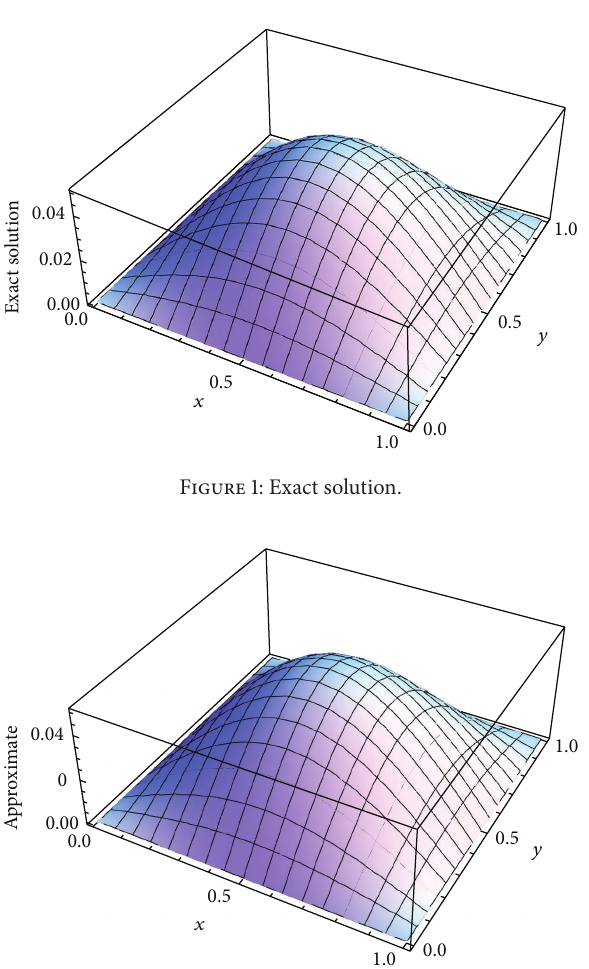
Figure 2: Approximated solution for the 4 first